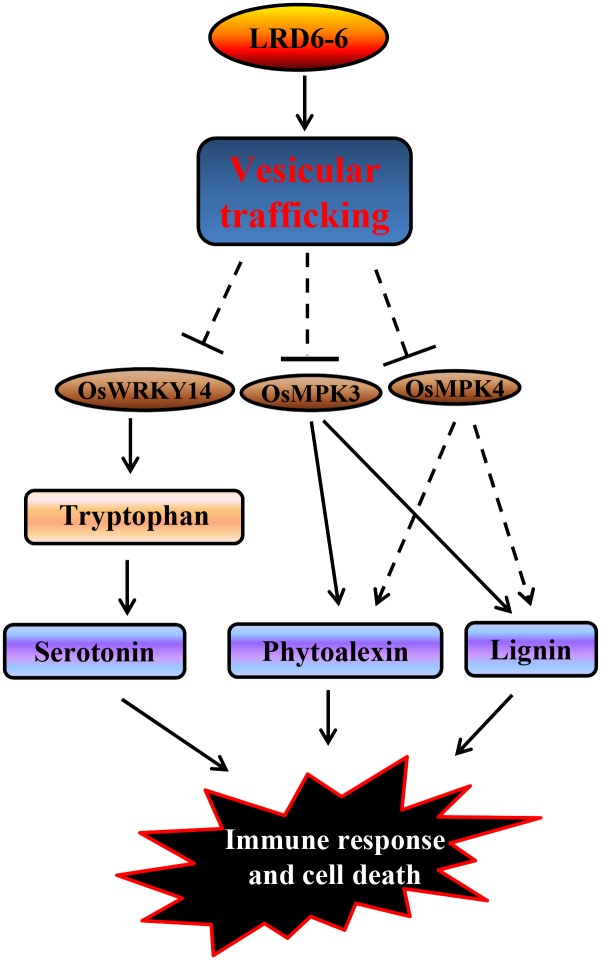
Predicted mode of Lrd6-6 in regulation of innate immunity and cell death in rice.LRD6-6 regulates the MVBs-mediated vesicular trafficking thus inhibits the expression of genes involved in immunity such as OsWRKYK14, OsMPK3 and OsMPK4, and then represses the accumulation of antimicrobial metabolites and prevents activation of PR genes to avoid activation of immunity response and cell death in rice.